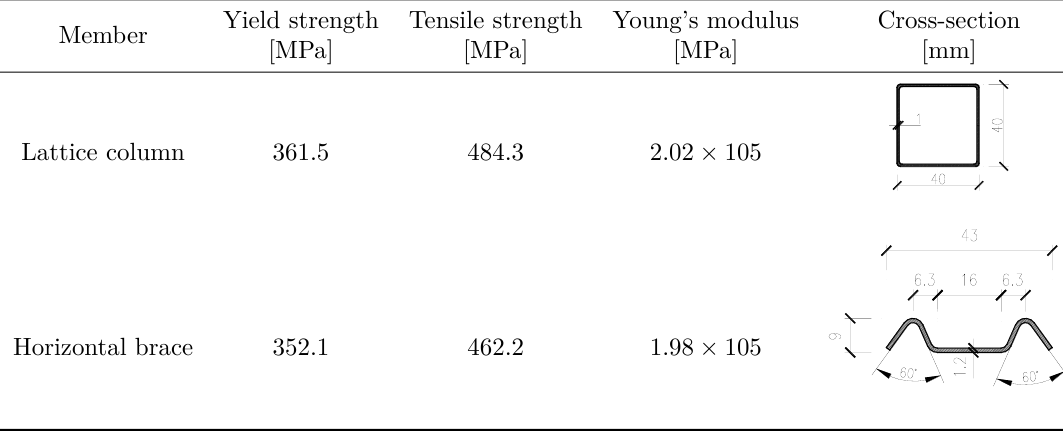
Table 2. Mechanical properties and cross-section size of light gauge steel.